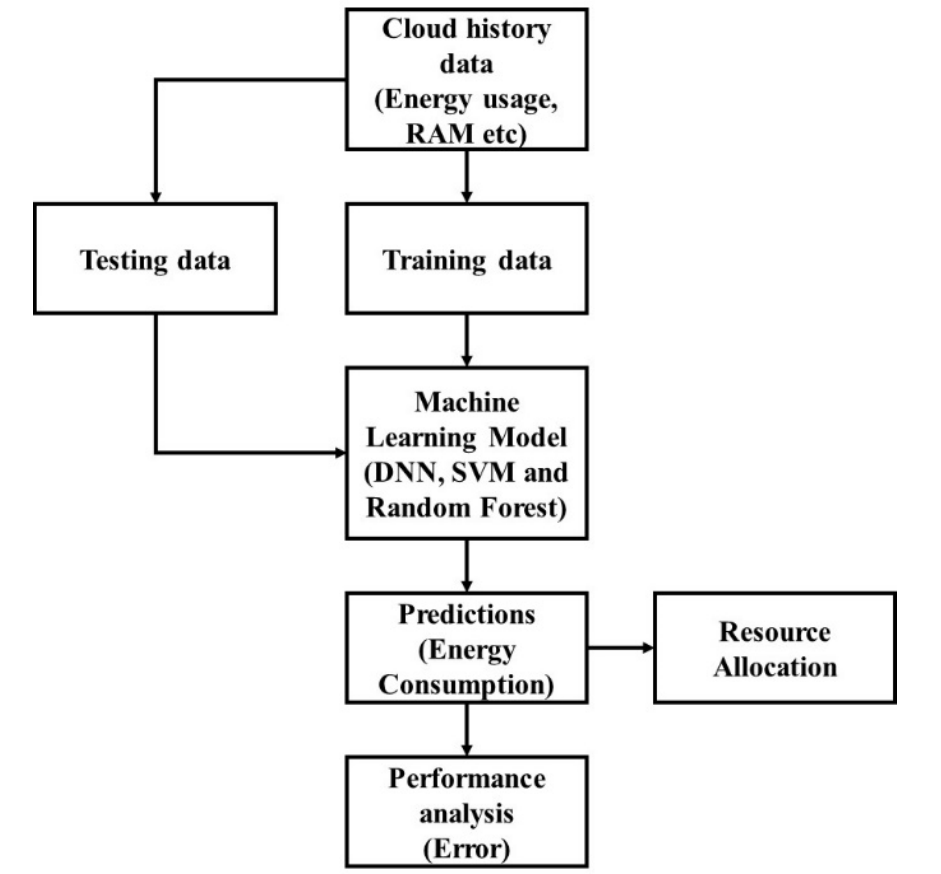
Figure 4. Machine learning model for energy consumption prediction in cloud. Junaid et al. [38] proposed CSO and SVM methods for the load balancing algorithm in cloud to reduce the energy consumption. The file type is classified in the cloud and SVM is applied to classify the files one by one. The CSO method is applied to distribute the files based on the load on VM to reduce the energy and increases the performance. Simulation results show that CSO method has higher performance in energy efficiency. The SVM method has the limitation of lower performance in handling the imbalance data. Shapi et al. [39] proposed SVM, ANN and k-NN methods for the prediction model of energy in the Microsoft-Azure cloud-based machine learning method. The model was tested in the real time data and result showed that prediction had higher performance in energy management. The feature analysis in the prediction model had the lower perfor- mance that affects the performance of the method. Susac et al. [40] applied DNN, Rpart regression, and random forest to predict the energy consumption in the Croatian Public Sector building. The DNN model has the highest performance in the prediction and VM allocation in the cloud. The DNN method has the limitation of the overfitting problem that affects the performance of the model. The general architecture of DNN that it is implemented in the prediction of network energy consumption as shown in Figure